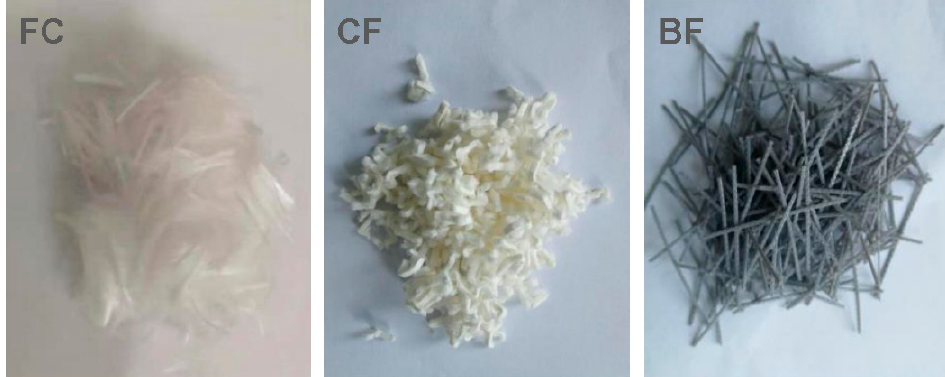
Figure 2. Morphology of the three types of fibers. Table 2. Fiber physical and mechanical properties index.